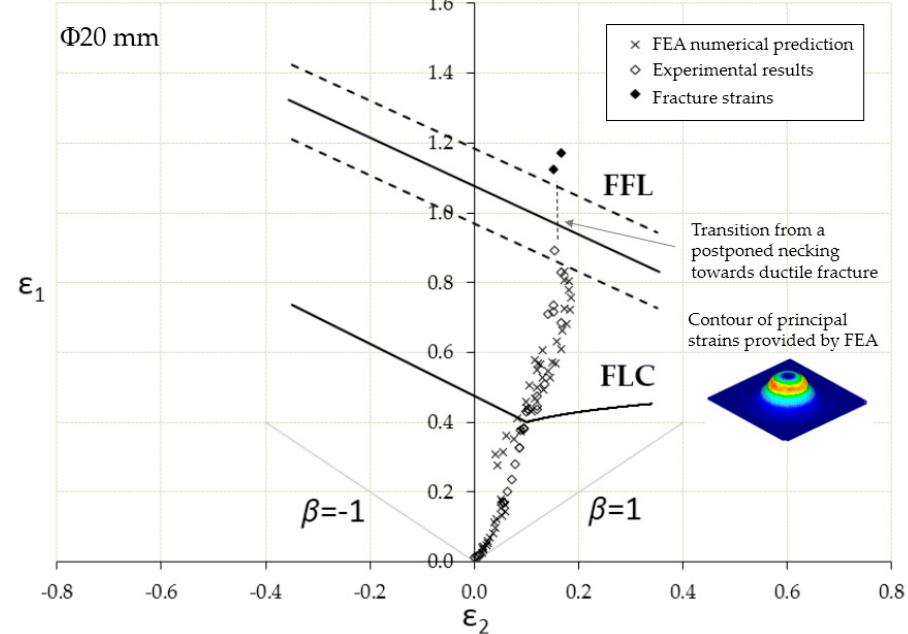
Figure 11. Numerical predictions versus experimental values of principal strains within the FLD of the material in the final testing part deformed by SPIF using a tool of Ф 20 mm diameter.